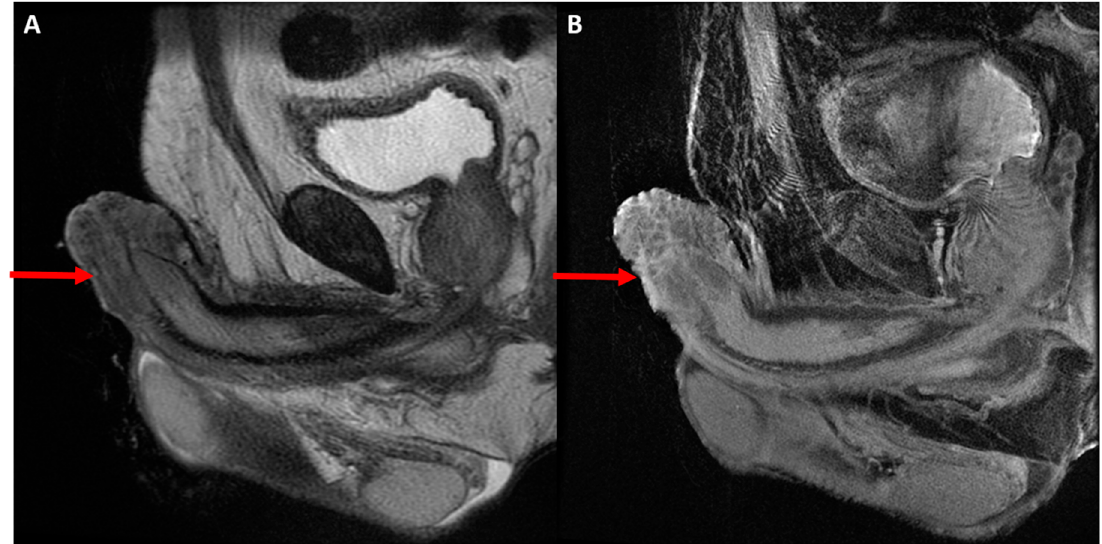
Figure 2. 51-year-old male with newly diagnosed penile cancer of the glans penis presents for MRI to evaluate the depth and degree of local invasion and for surgical planning. Sagittal T2-weighted ( A ) and T1 fat suppressed postcontrast ( B ) images demonstrate the known mass at the glans penis with intermediate T2 signal intensity and hypoenhancement invading into the adjacent corpora. Of note, the degree of corporal invasion is more clearly demonstrated on postcontrast images in this case.